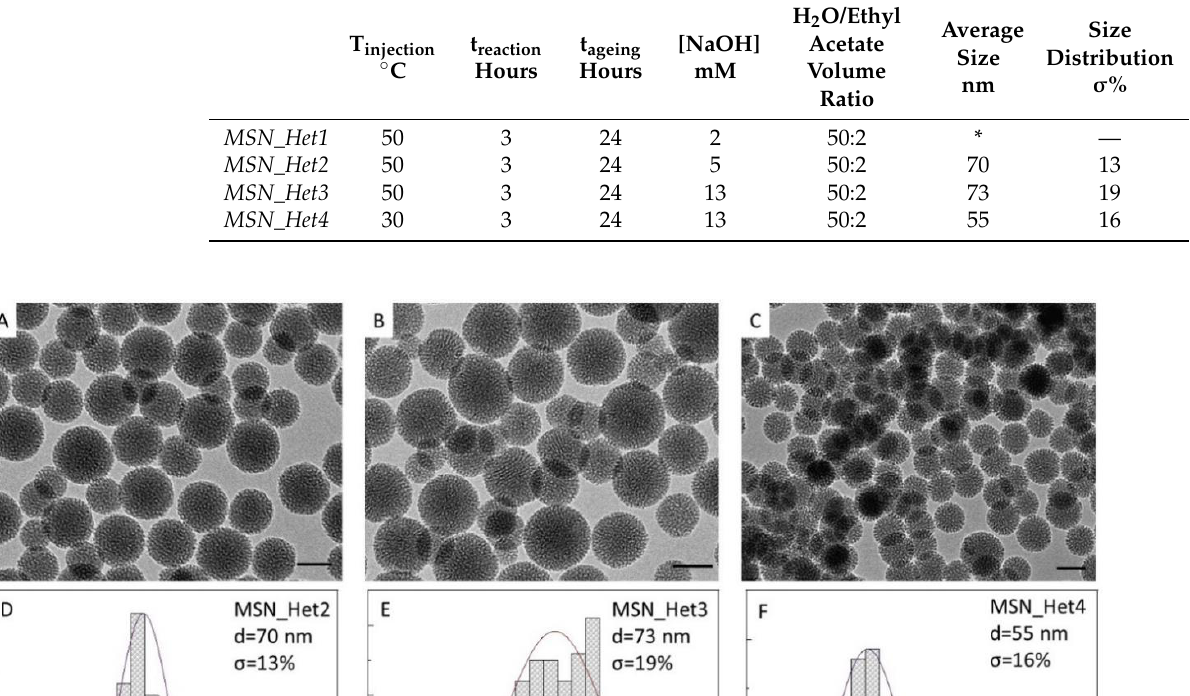
Table 2. Reaction conditions for the MSNs synthesized in a two-phase system and average size and size distribution of the resulting particles determined from the TEM analysis. (*) As shown in Figure S4B in the Supplementary Materials a siliceous network rather than MSNs forms.